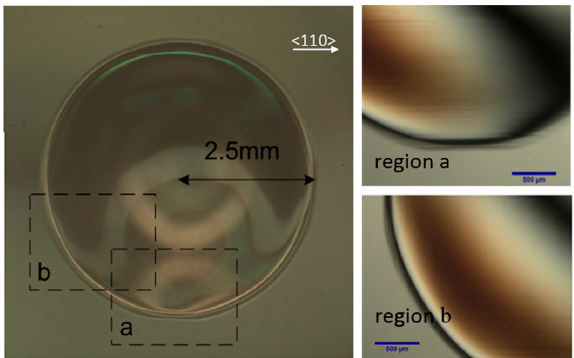
Figure 10. Top view optical microscope photo of diaphragm with a radius of 2.5 mm after annealing 900 °C for 21 h.